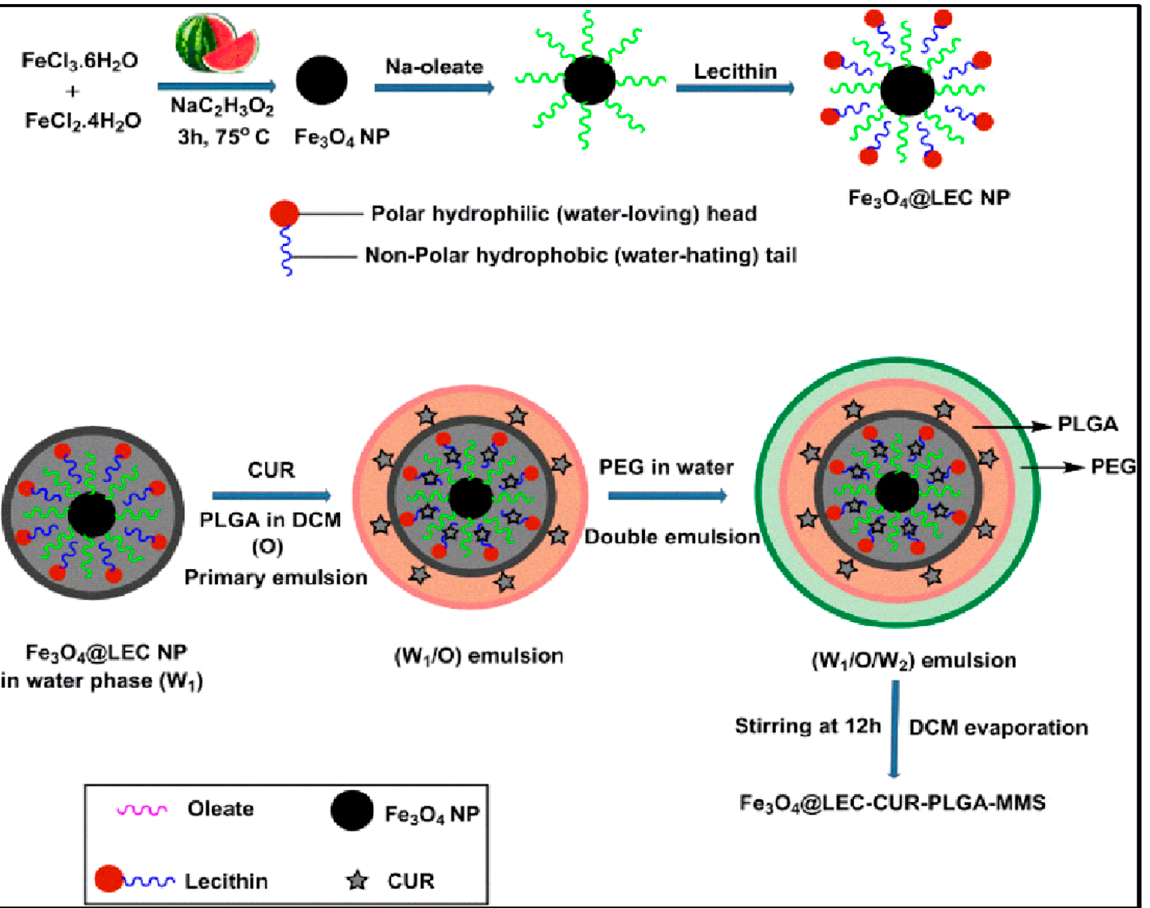
Figure 3. Schematic representation of Fe 3 O 4 @LEC–CUR–PLGA–MMS particle synthesis. Reproduced with permission from [5].